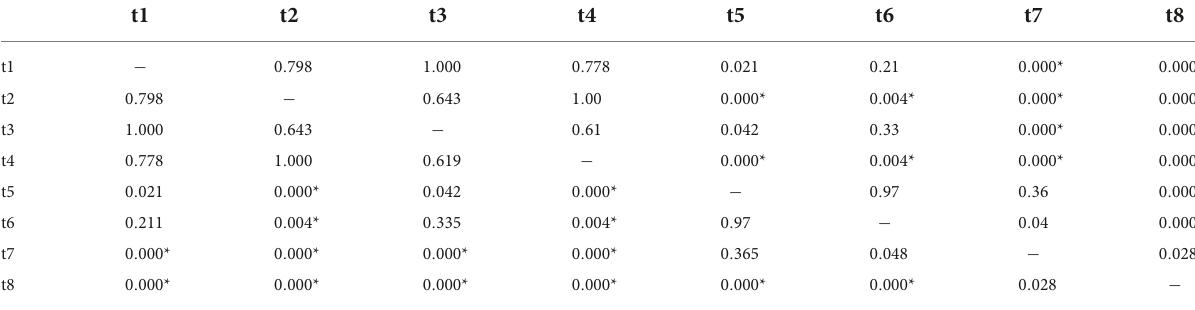
TABLE 3 Pairwise comparison of the treatments for flavonoids by Scheffe post hoc test.